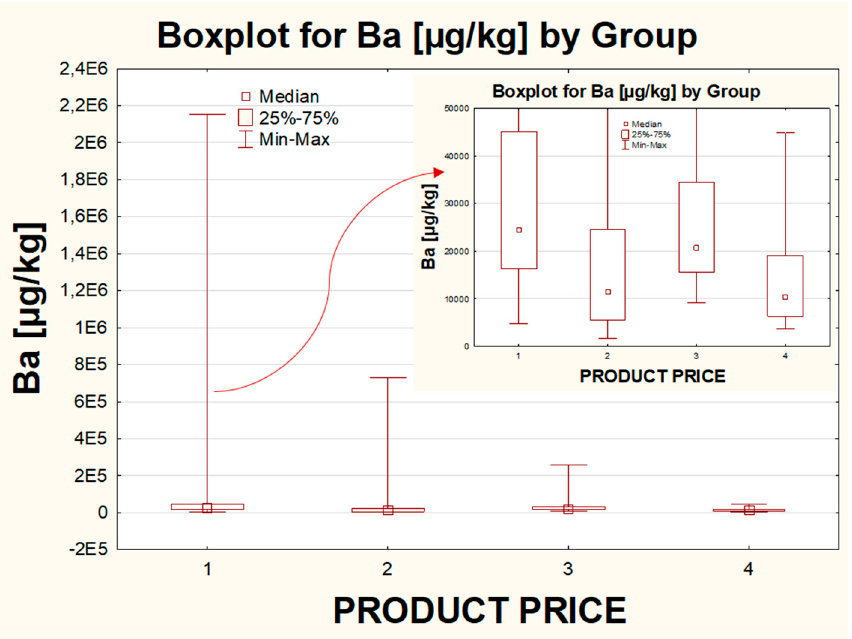
Figure 3. The box–whisker plot representing the influence of the product price on the concentra- tion of Ba (µg/kg), where the cheapest products—group “1”, medium price products—group “2”, expensive—group “3” and very expensive—group